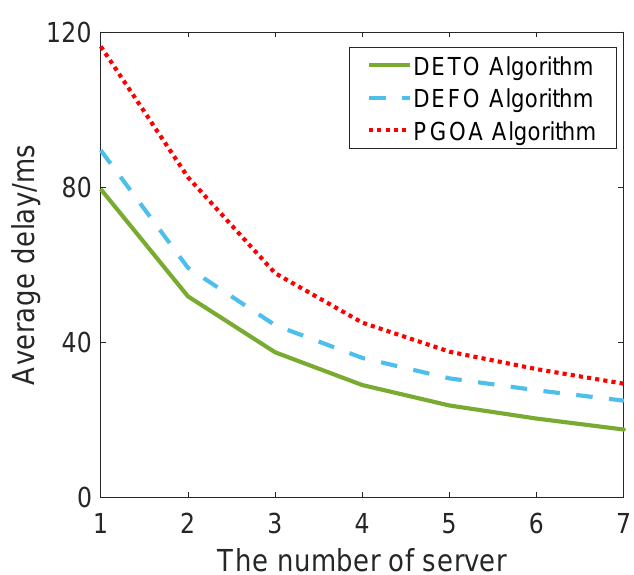
Figure 4. The delays for different networks.